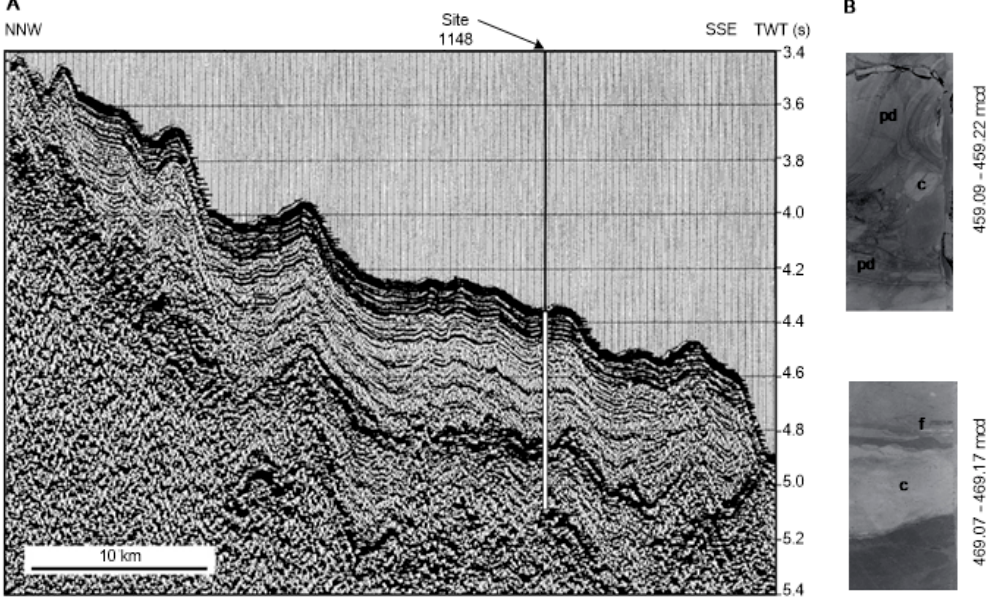
Figure 4. (A) Seismic profile through ODP Site 1148, showing a prominent reflector at section II,